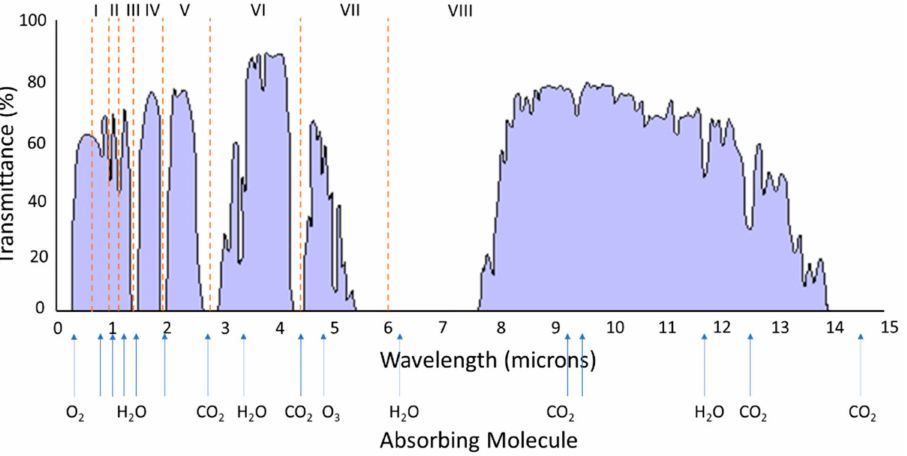
Figure 6. Atmospheric transmittance across the spectral range at sea-level along an 1820 m path. Adapted from